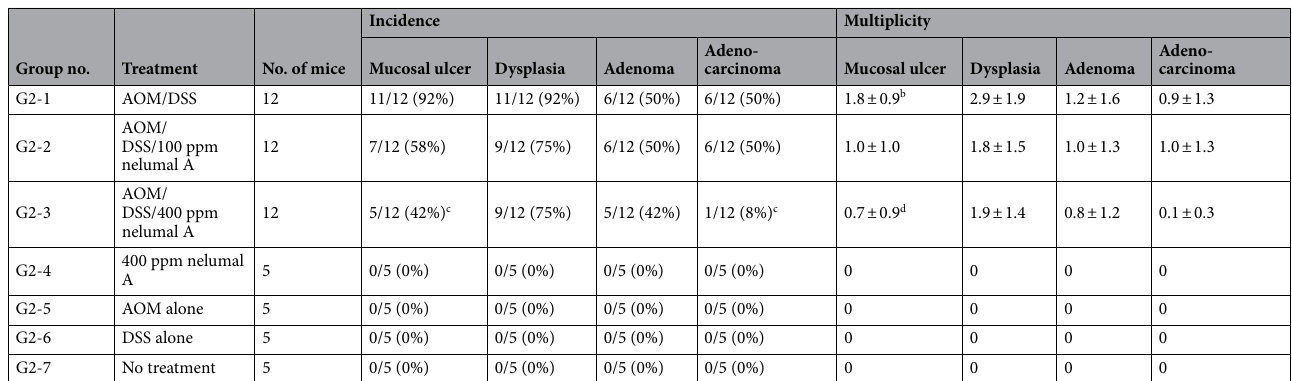
Table 2. Incidence and multiplicity of colonic mucosal ulcer, dysplasia, adenoma and adenocarcinoma in the experiment 2. a Number of lesions per mouse. b Mean ± SD. c Significantly different from group 1 by Fisher’s exact probability test ( P < 0.05). d Significantly different from group 1 by Tukey–Kramer multiple comparison test ( P <